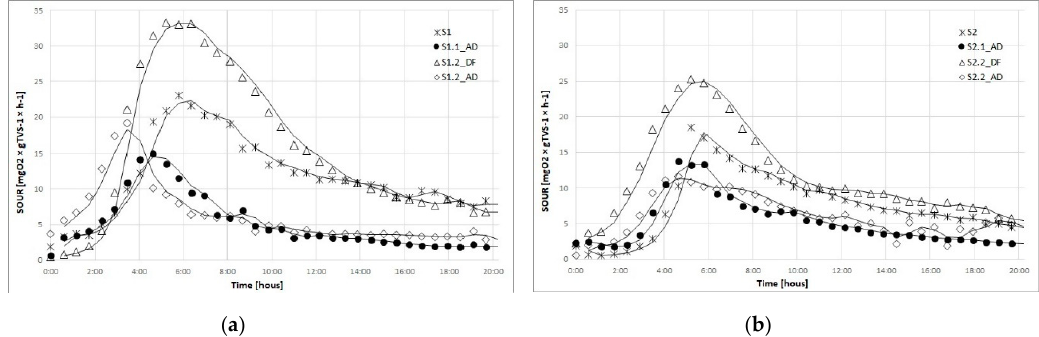
Figure 3. SOUR trend during the two configurations studied: digestion process ( a ) and co-digestion process ( b ).